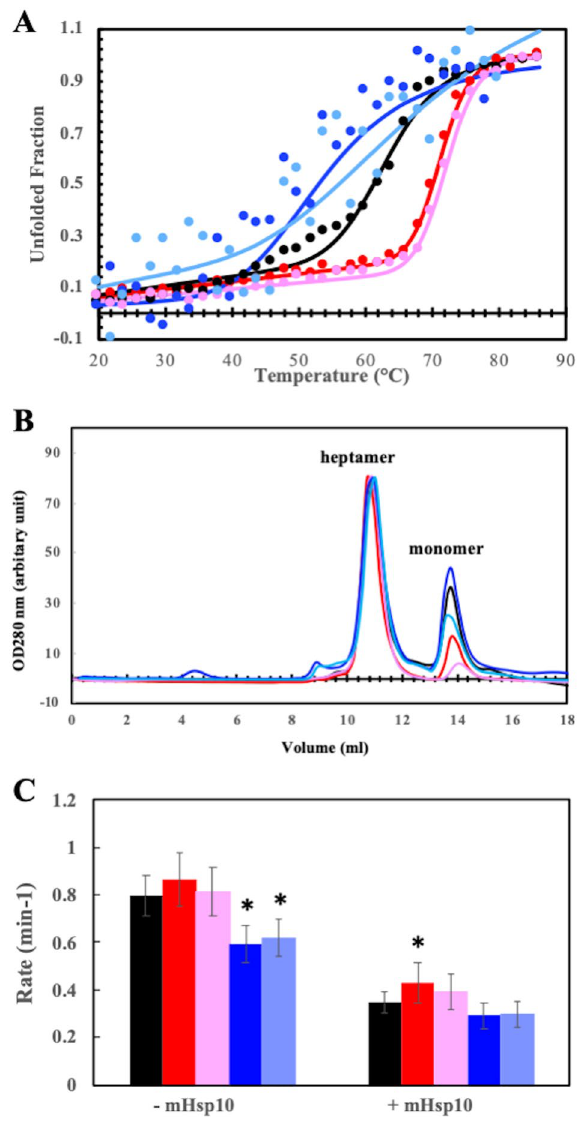
Figure 2. V72I mutation increased structural stability and ATPase activity. ( A ) Representative thermal unfolding of mHsp60 proteins. Unfolded fraction is defined as (y-y N )/(y U -y N ) where y, y N , and y U are the molar ellipticity (ϑ 222 ) derived in Eq. (1). The solid lines are non-linear regression analysis using Eq. (1). The derived ∆H vh and T m values are listed in Table 1. ( B )Size exclusion chromatographic profiles of mHsp60 proteins 96 h after purification at 4 °C. The profiles were scaled to the heptameric peak (V = 10.8 ml). ( C )The ATPase activity of mHsp60 proteins in the absence and presence of cochaperonin mHsp10. Rates of ATPase activity, errors of standard deviation, the number of measurement, and p-value associated with one-way analysis of variance are listed in Table 2. * p-value < 0.05. Wild type mHsp60 (black), mHsp60 V72I (red), mHsp60 V72I/GMless (pink),